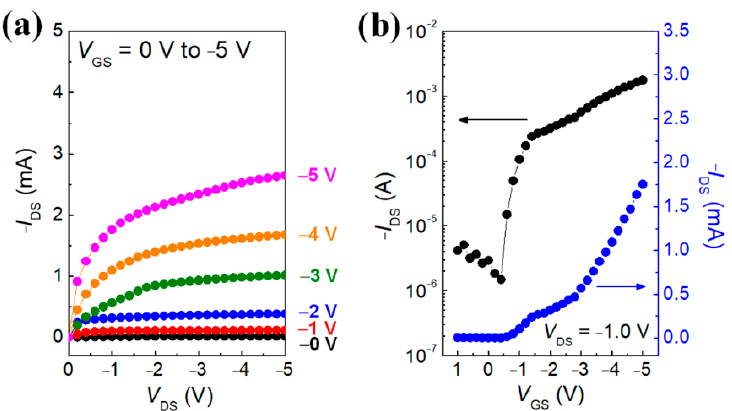
Figure 9. ( a ) Output and ( b ) transfer characteristics of textile-OFET using pure P3HT as an active channel material.